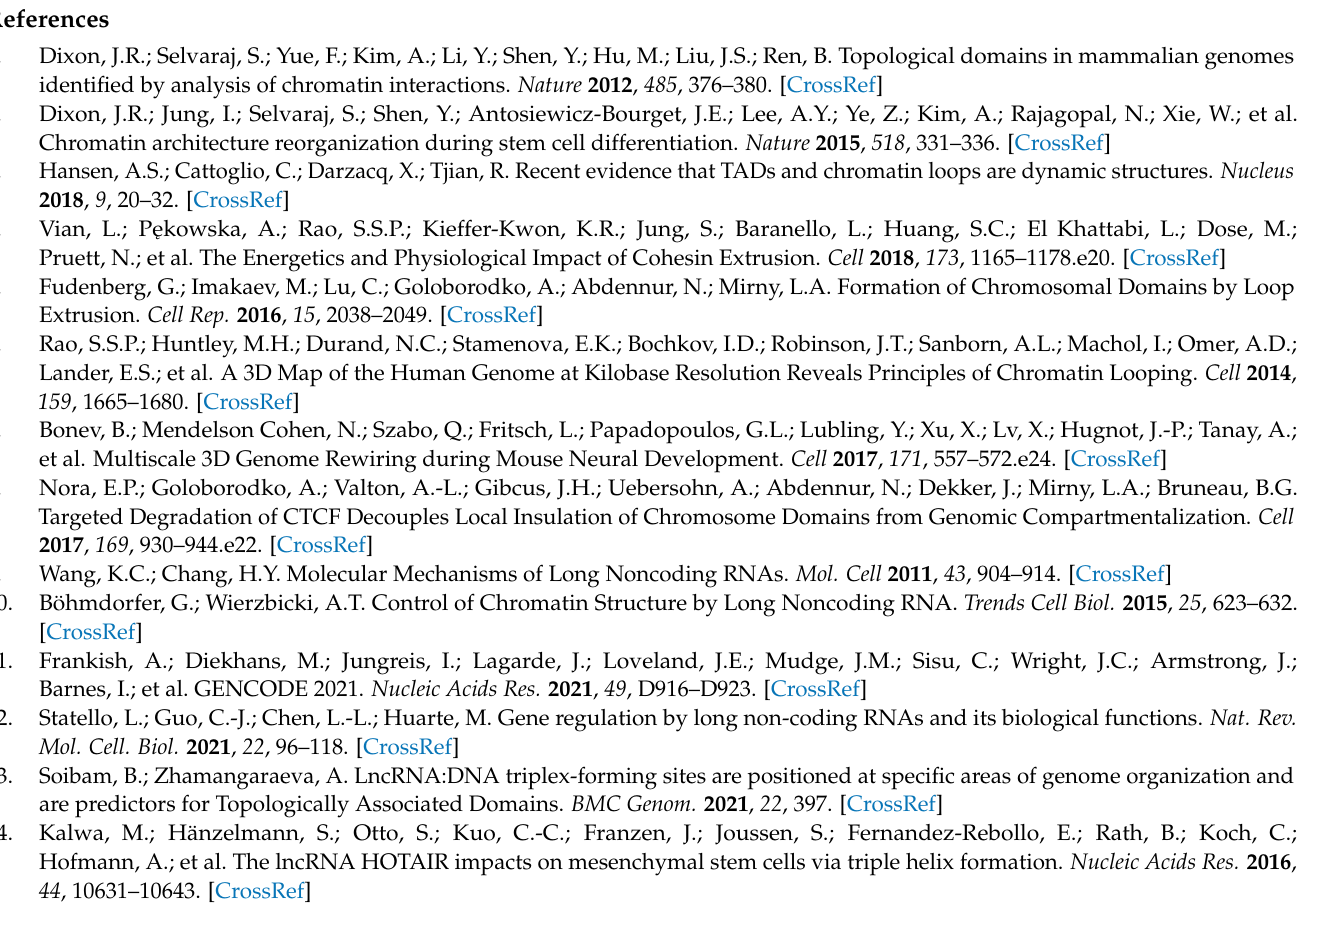
Table S1: LncRNAs with fold change >2 at CP stage compared to day 0 of cardiac differentiation reported by Kuo et